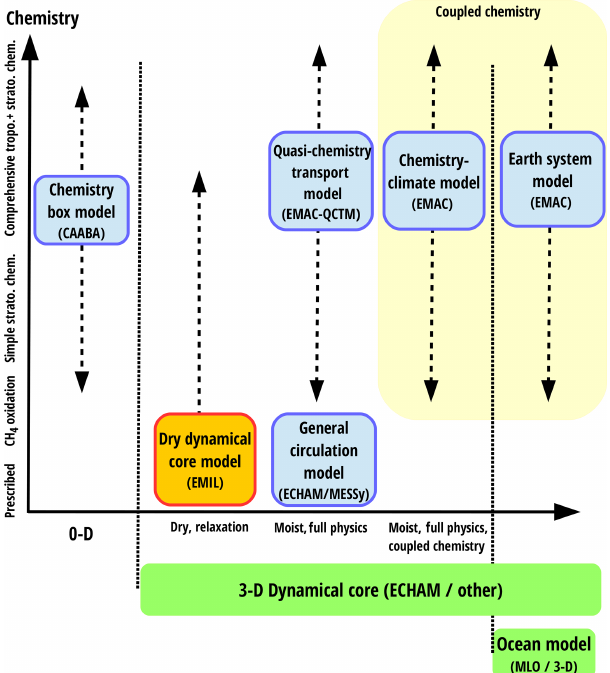
Figure 1. Schematic of the MESSy model hierarchy with existing (blue) model setups and the model setup described in this paper (red). Model setups are displayed as function of their complexity in dynamics/physics/compartments (horizontal axis) versus com- plexity in chemical mechanism (vertical axis). The horizontal axis ranges from (left) a zero-dimensional box model to (middle) mod- els with an atmospheric dynamical core (ECHAM or other imple- mented dynamical cores in MESSy), but with varying physical com- plexity, and to (right) models with an additional ocean model (full 3-D or mixed-layer ocean). The vertical axis displays the chemical complexity that can gradually be increased from prescribed tracer concentrations for the radiation scheme to a more and more com- prehensive set of chemical reactions. The chemistry can be used diagnostically only or in a coupled manner (yellow